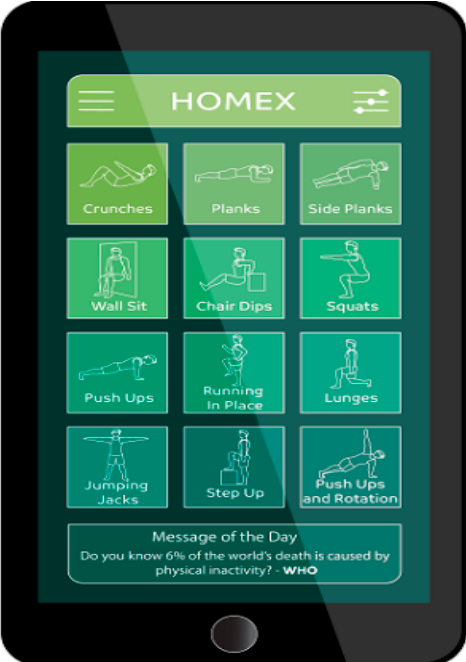
Figure 2. Twelve exercise types presented to participants to choose from their most/least preferred.